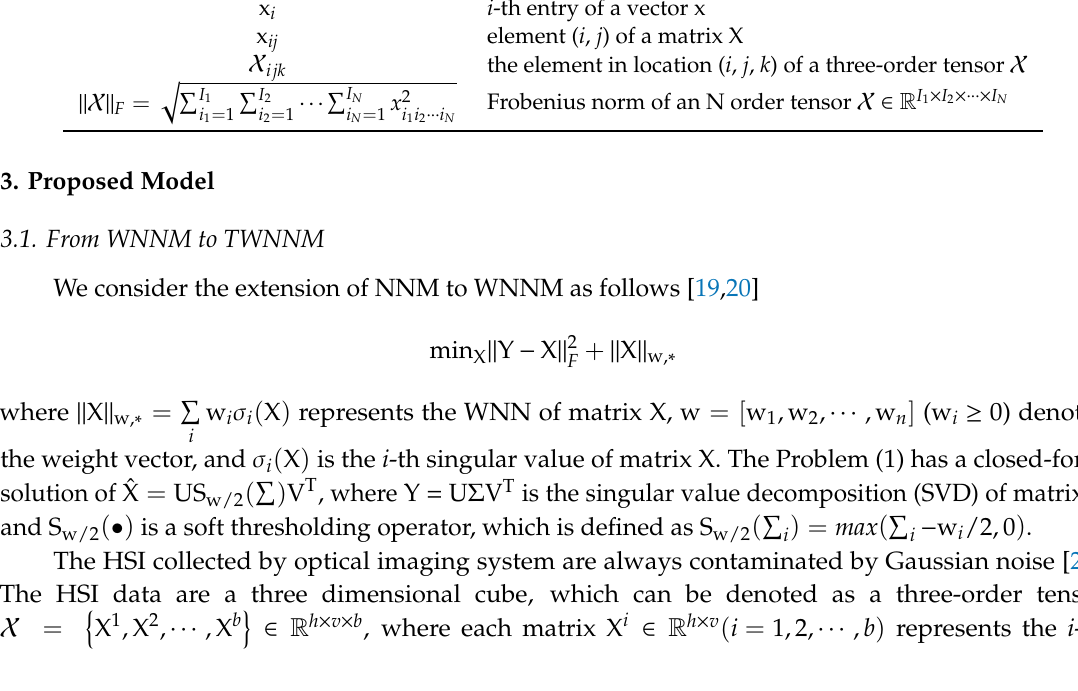
Table 1. The main mathematical symbols used in the paper and their corresponding explanations. Natation Description x , x, X, X scalar, vector, matrix, tensor x i i -th entry of a vector x x ij element ( i , j ) of a matrix X X ijk the element in location ( i , j , k ) of a three-order tensor